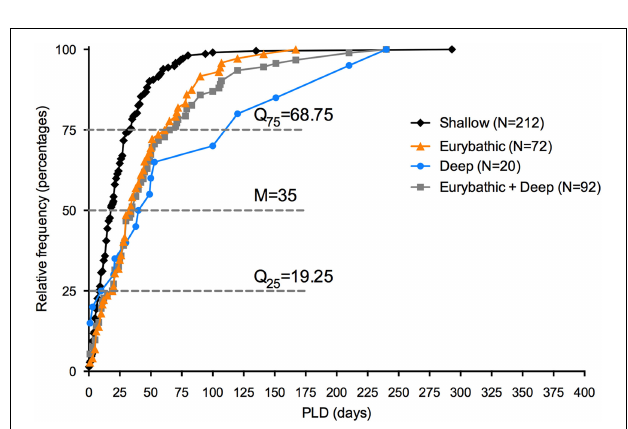
FIGURE 2 | Mean and standard deviation of minimum (left), maximum (middle) and median (right) PLD values for shallow, eurybathic and deep-sea species. The value of 660 days determined for Sclerasterias tanneri was not included.